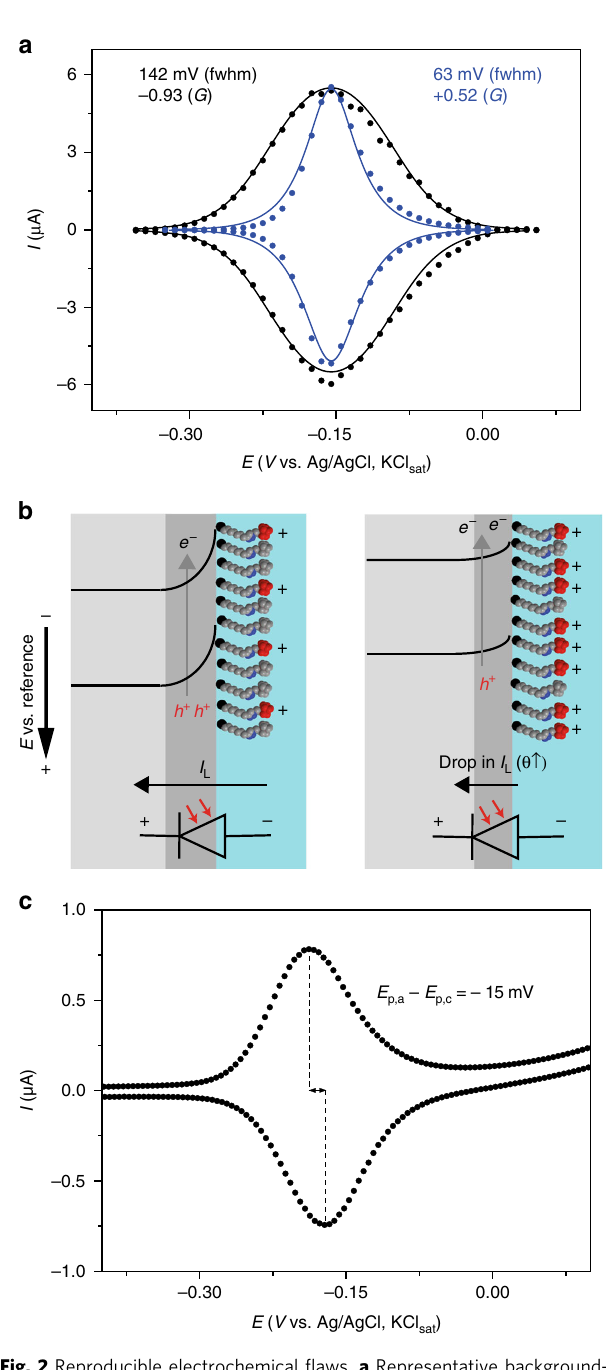
Fig. 2 Reproducible electrochemical fl aws. a Representative background- subtracted voltammograms (100 mV s − 1 , 1.0 M HClO 4 ) for S-2 samples on n-type Si(111). Simulated traces (solid black line) for as-prepared samples (symbols) indicate repulsive forces dominate the electrostatic balance of the monolayer system. Applying a potential step of 0.3 V for 140 s shift the balance in favor of attractive interactions (blue line and symbols). Averaged values from cathodic and anodic peaks of experimental fwhm ’ s and re fi ned Frumkin G values appear as labels in fi gure. b Distortion of the semiconductor side of the barrier for a photoanode due to the presence of an electrochemically induced dipole layer of surface charges. The depiction of the photodiode used for the simulations indicates downward fl ip of the bands due to the positive ferriceniums units and the changes to the photogenerated anodic current. c Inverted voltammograms for S-2 samples (25 mV s − 1 , n-type). E p,c is 15 mV higher than E p,a . The hydrosilylation reaction time ( S-1 ) is 10